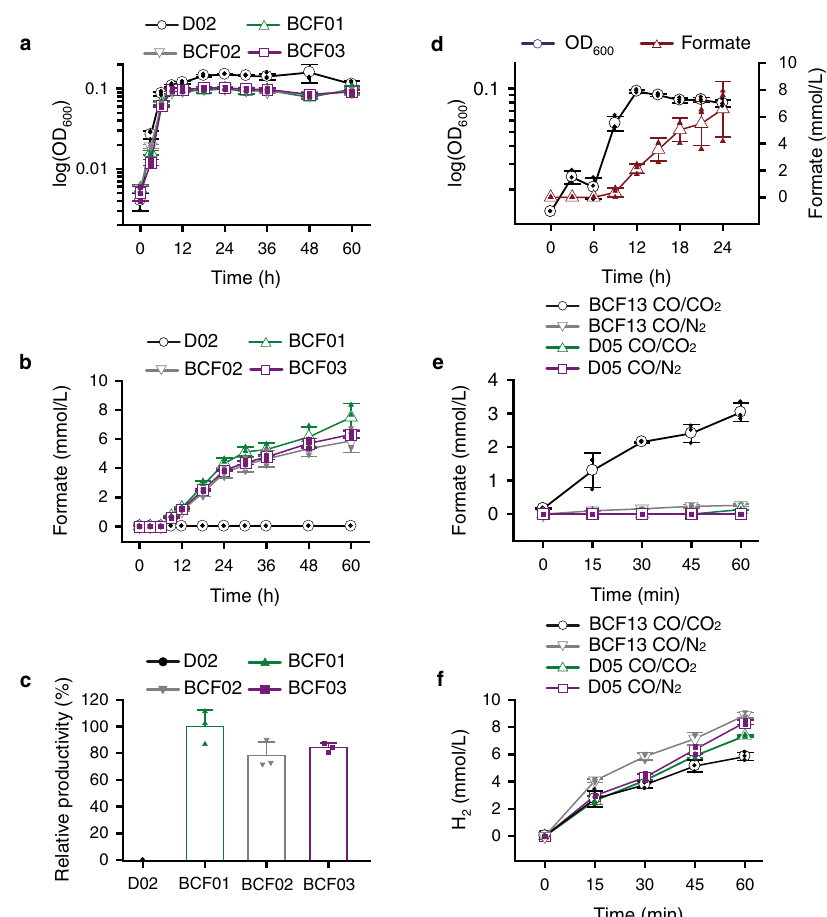
Fig. 1 CO-dependent formate production. a , b Cells were incubated at 80 °C with CO gas in serum vial. Cell growth ( a ) and formate production ( b ) of the T. onnurineus D02 (parental strain), BCF01 ([GGGGS] 1 ), BCF02 ([GGGGS] 2 ), and BCF03 ([GGGGS] 3 ). c Relative formate productivity at 24 h has compared between BCF01 set to 100% and the other strains. d Cell growth and formate production from T. onnurineus BCF13. e , f Formate ( e ) and H 2 ( f ) production from cell suspensions of T. onnurineus BCF13 (with linker) and T. onnurineus D05 (without linker); cells (OD 600 = 0.5) were incubated with CO/ CO 2 (50:50 v/v) mix gas or CO/N 2 (50:50 v/v) mix gas in modi fi ed PBS buffer at 80 °C. The data were presented as the average ± standard deviation (SD) (open symbol), and all the individual data points were shown (closed symbol). Error bars represent ± SD ( n =